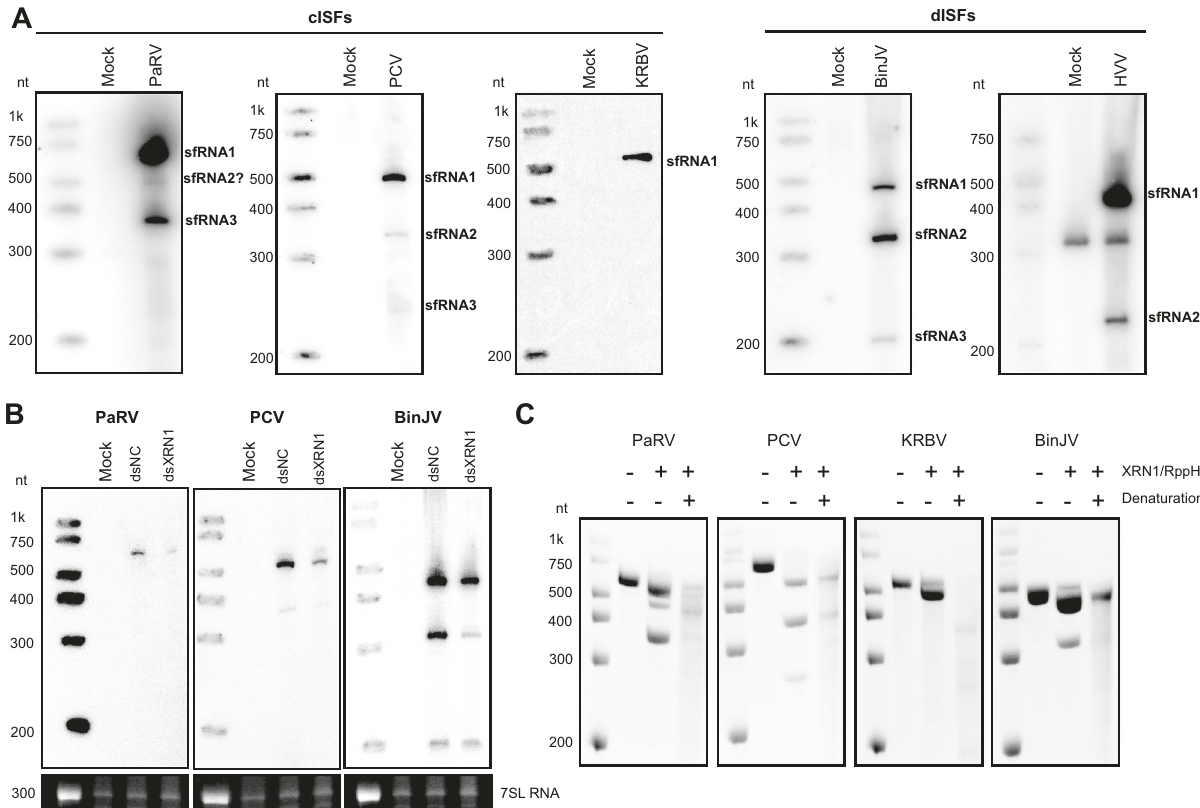
Fig. 1 Classical and dual host-associated ISFs produce sfRNAs by employing XRN1-resistance mechanism. A Northern blot detection of sfRNAs produced by ISFs. For PaRV, PCV, BinJV and HVV C6/36 cells were infected at MOI = 1. Total RNA was isolated at 5 dpi. For KRBV, total RNA was isolated from virus-positive and virus-negative (Mock) Anopheles mosquitoes. RNA was then used for Northern blotting with the probe complementary to the last 25nt of viral 3 ’ UTRs. B The effect of XRN1 knock-down on the production of sfRNAs by ISFs. Aag2 cells were transfected with dsRNA against Aedes aegypti XRN1 (dsXRN1) or GFP (dsNC) and infected with respective viruses at MOI = 1 at 24hpt. At 48hpi, total RNA was isolated from the cells and used for Northern blotting as in ( A ). Bottom panels represent the Et-Br staining of the gels used for Northern transfer with 7SL cellular RNA visualised as a loading control. C In vitro XRN1 resistance assay with ISF 3 ’ UTRs. RNA corresponding to 3 ’ UTRs of ISFs was transcribed in vitro, brie fl y heated and then refolded by gradual cooling to 28 °C or placed on ice to preserve the denatured state. Samples were then treated with puri fi ed XRN1 and RppH (to convert 5 ’ PPP into 5 ’ P) and analysed by electrophoresis in denaturing PAAG. Gels were stained with ethidium bromide (Et-Br). All images are representative of at least two independent experiments that produced similar